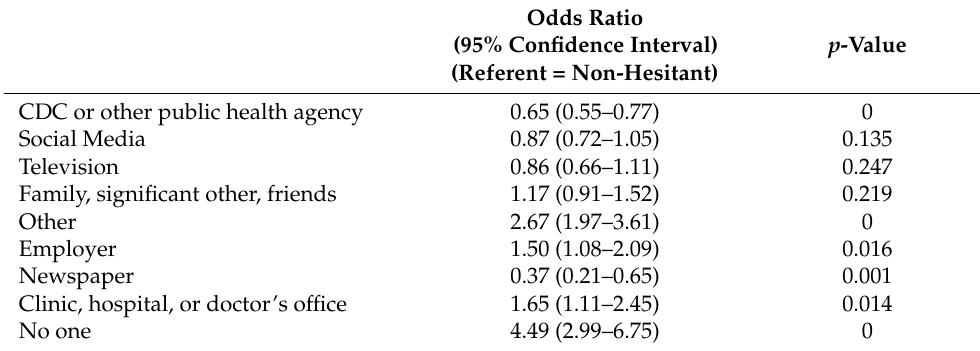
Table 6. Associations between sources of health information and vaccine